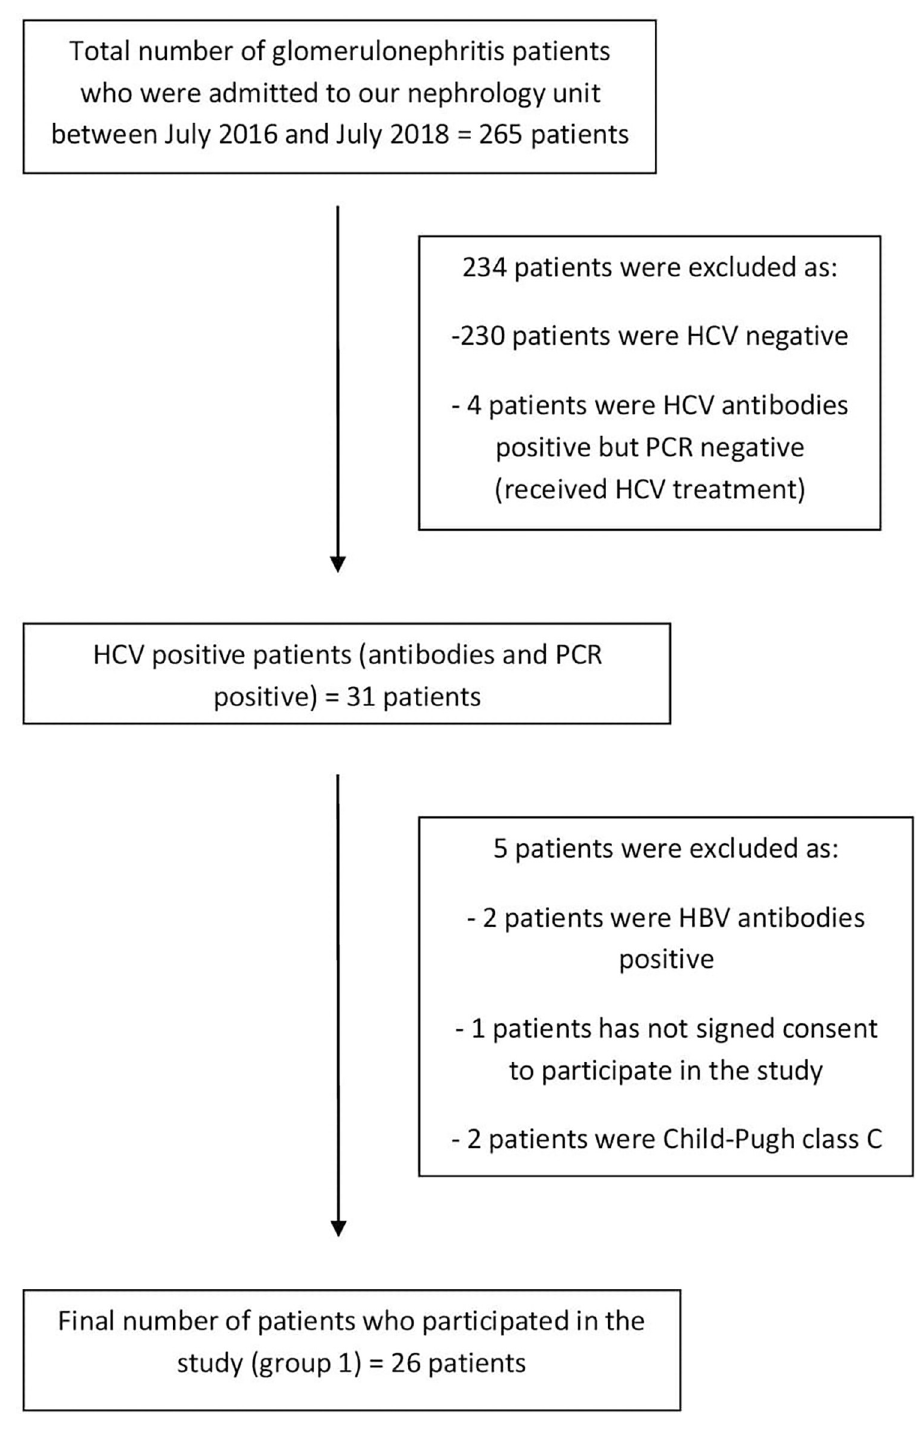
Fig 1. Flow chart for patients‘recruitment to the study.